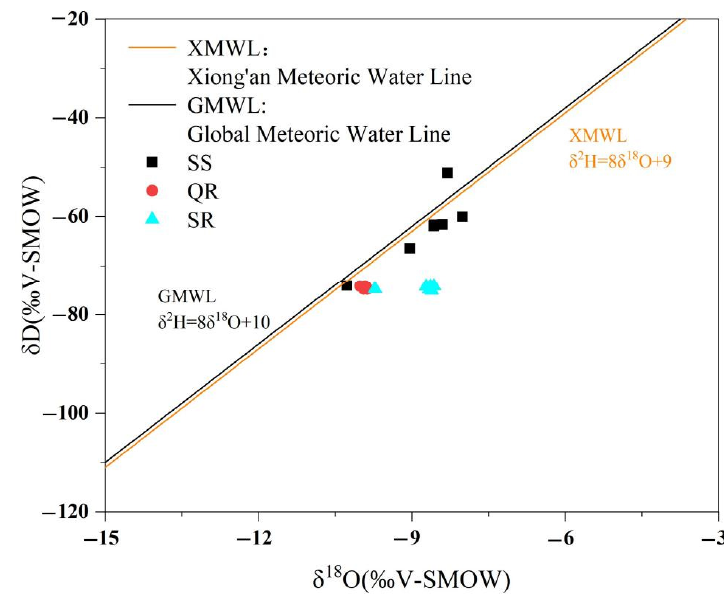
Figure 5. Hydrogen and oxygen isotopic abundance in selected water samples.